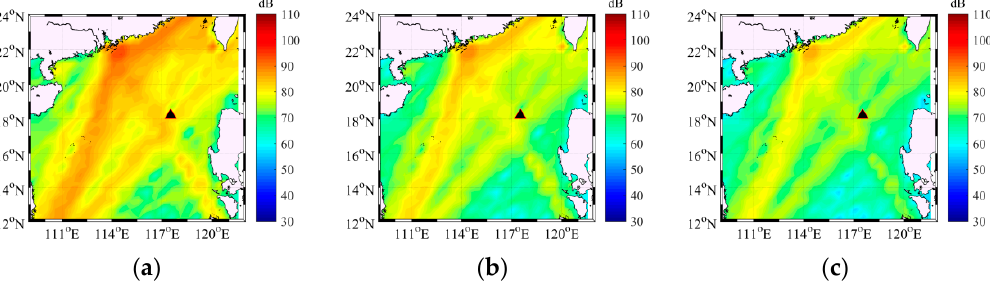
Figure 12. The average shipping noise source intensity based on VOS for frequency of ( a ) 50 Hz ( b ) 100 Hz and ( c ) 150 Hz (unit: dB re 1 μ Pa 2 /Hz/m 2 @ 1 m).